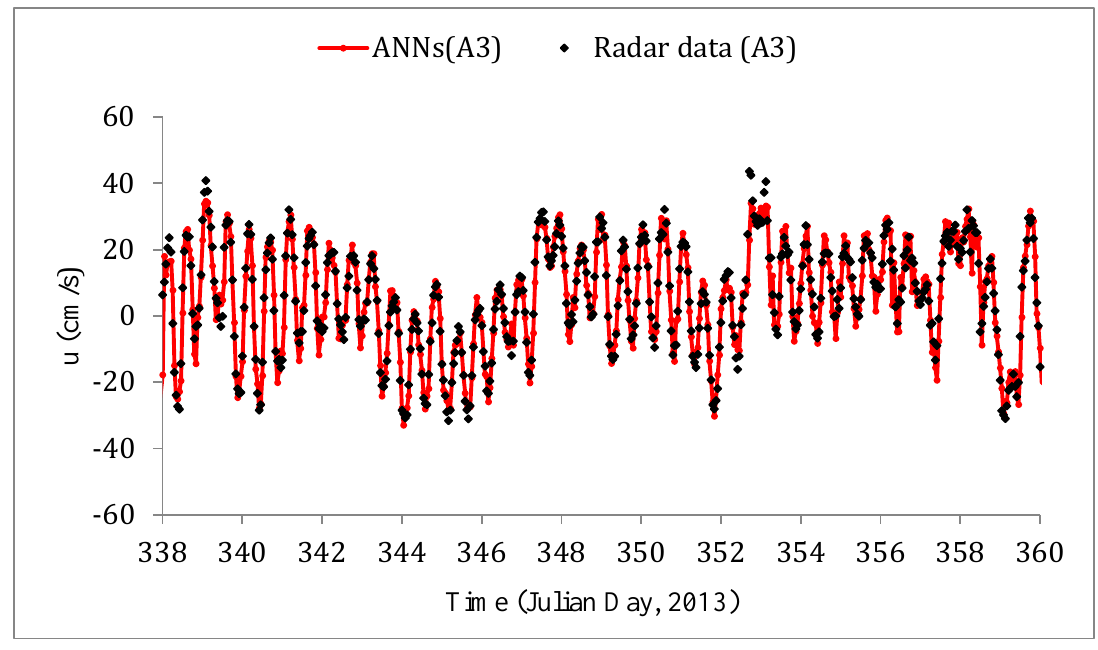
Figure 6. Forecasts of u velocity component at A3 (Model U8, 1 h forecast window).